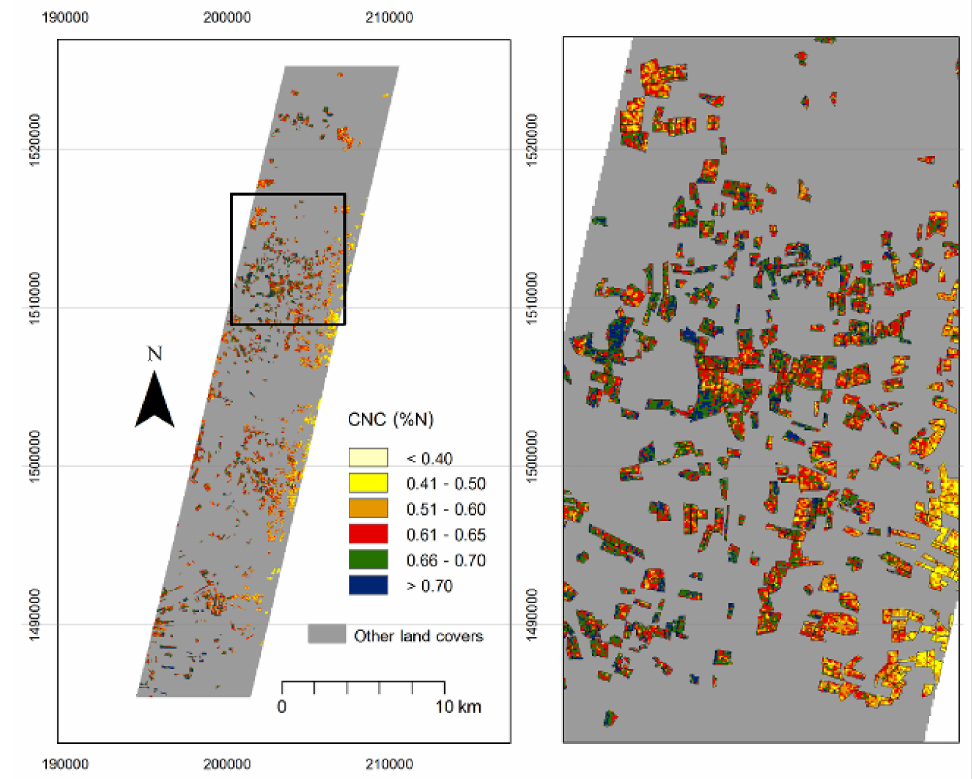
Figure 24. Density of canopy nitrogen concentration (% nitrogen) in sugarcane fields; the spatial map was generated by Miphokasap and Wannasiri [127]; The different densities were produced using a SVR model and Hyperion satellite